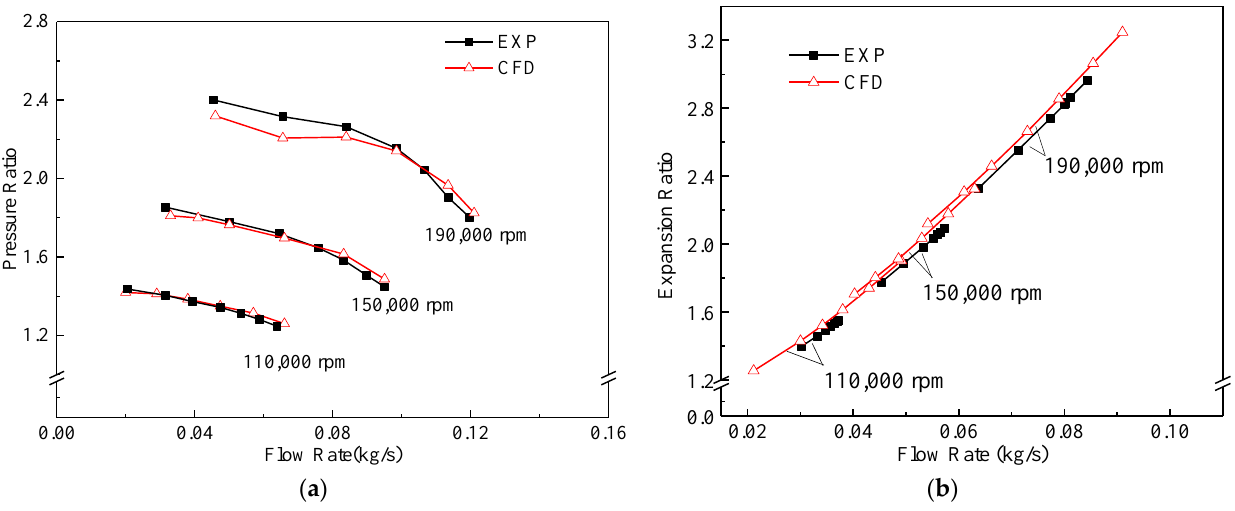
Figure 7. ( a ) Test validation of the original compressor; ( b ) test validation of the original turbine.